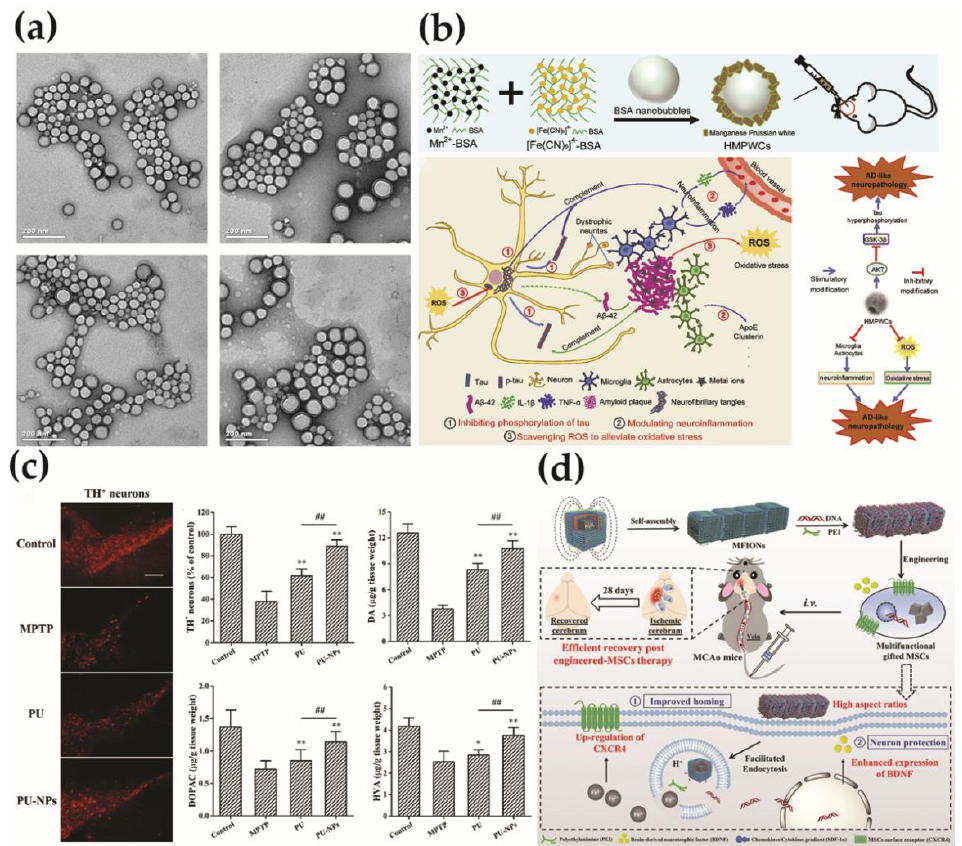
Figure 1. ( a ) Transmission electron micrographs of NP, T 3 -NP, Q 3 -NP, and T 3 Q 3 -NP, respectively, reprinted from [5]. Copyright 2014, with permission from Elsevier; ( b ) schematic illustration of the preparation of HMPWCs and the effect of HMPWCs on the Tau-related AD-like neuropathology, reprinted from [7]. Copyright 2020, with permission from Elsevier; ( c ) PU-NPs reduce neurotoxicity induced by MPTP, reprinted with permission from [17] Copyright (2019) American Chemical Society; ( d ) schematic illustration of MFION-based engineering of MSCs for the recovery post-ischemic stroke, reprinted from [29]. Copyright 2019, with permission from Weily. ** p < 0.01 corresponds to different treatments vs MPTP group; ## p < 0.01 corresponds to treatment with PU-NPs vs with PU group.